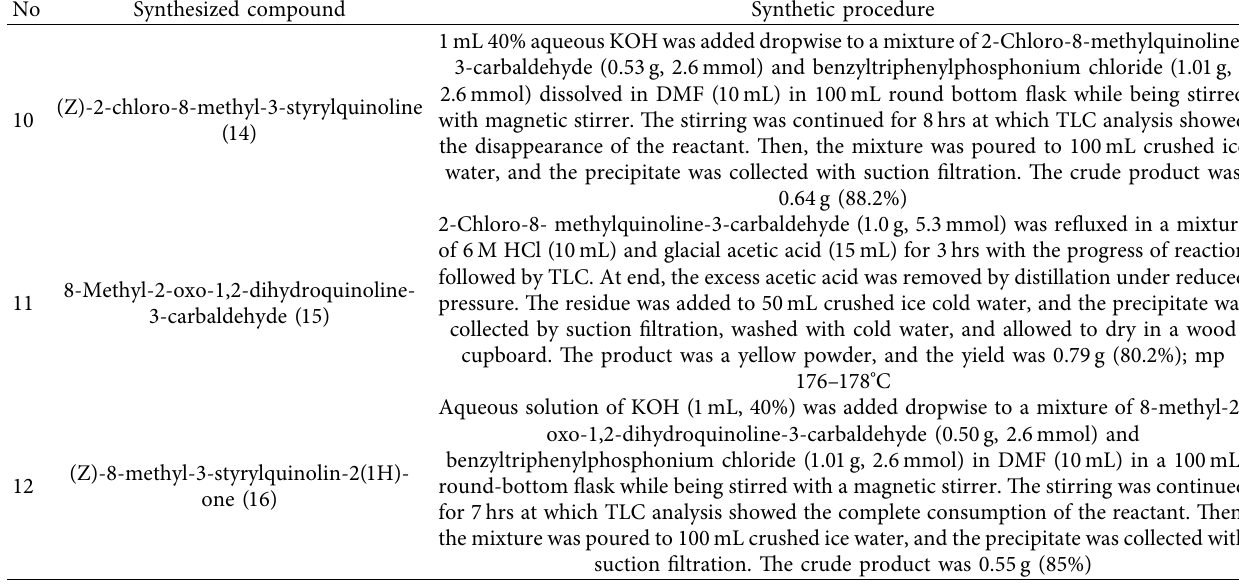
Table 4: Continued table of the synthesized compounds and their synthetic procedure.